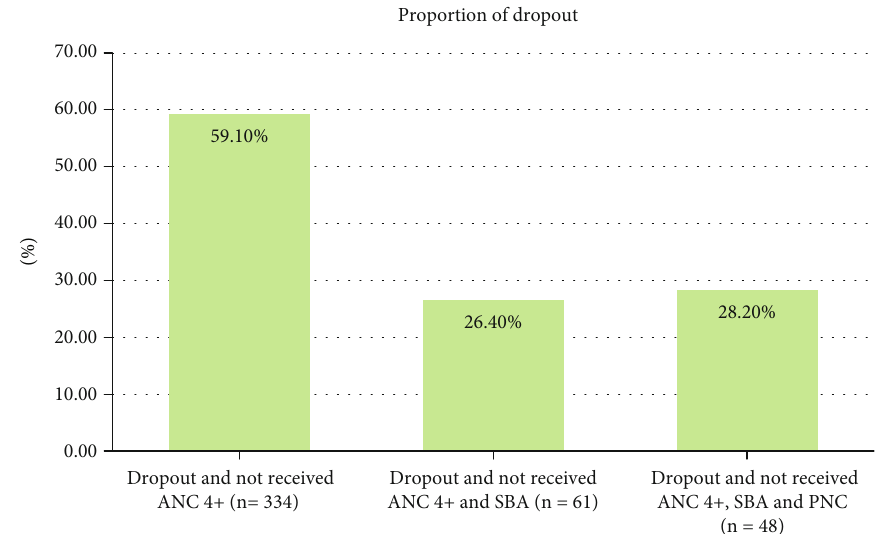
Figure 2: Proportion of dropout from the continuum of maternal healthcare services among women who give births in the last fi ve years, fi ndings from the primary health care project in northwest Ethiopian districts, September 2019 ( n = 565